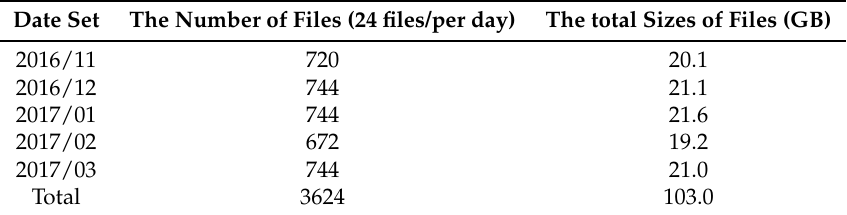
Table 1. Experimental resources extracted from Traffic Data Collection System (TDCS).